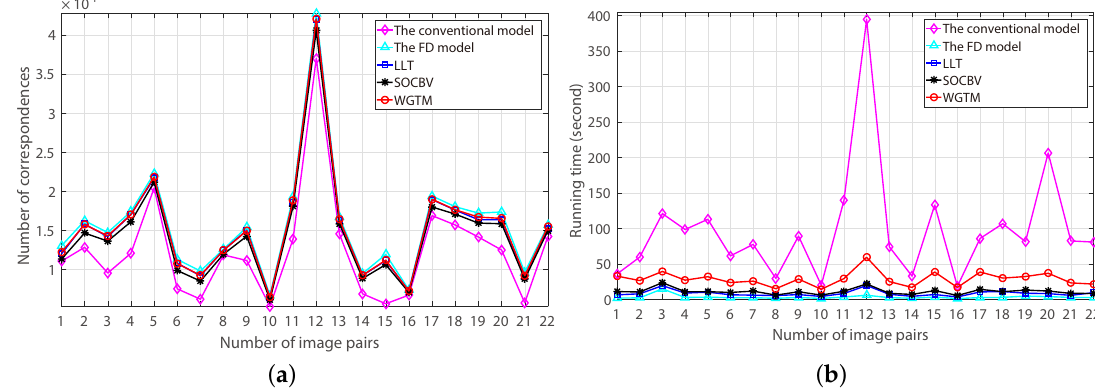
Figure 14. The number of resulting correspondences and running time of the conventional and the FD models and the three algorithms. ( a ) The numbers of putative-correspondences generated by the conventional model and the FD model (magenta and cyan lines) and of the correspondences preserved by the SOCBV, WGTM and LLT algorithms (black, red and blue lines respectively). ( b ) The running time of generating putative-correspondences by the conventional and the FD models (magenta and cyan lines) and of eliminating false-matches by the SOCBV, WGTM and LLT algorithms (black, red and blue lines